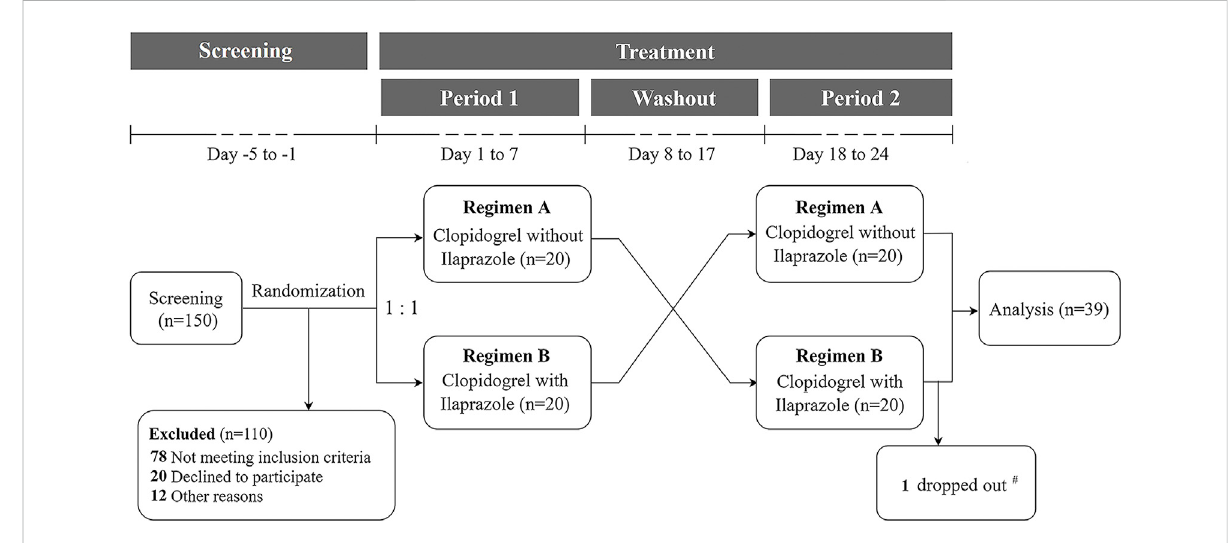
FIGURE 1 Flow diagram of the formal study. 150 subjects were screened and 40 were randomized in a 1:1 ratio into two protocols to receive clopidogrel 75 mgoncedailyfor7 days,andthenclopidogrel75 mgincombinationwithilaprazole10 mgoncedailyfor7 days( fi rstRegimenA,thenRegimenB; n =20),orviceversa( fi rstRegimenB,thenRegimen A; n =20),witha10-dayinterval between thetworegimens.#OnesubjectdroppedoutonDay 18 after the fi rst dosing of Regimen